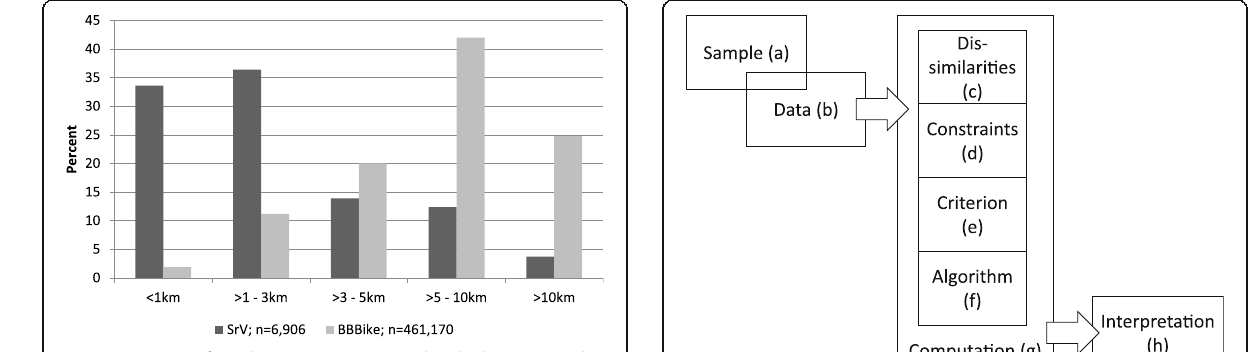
Fig. 3 Distances of BBBike requests compared with the municipal survey. The values describe the percentage of each length category on all trips in the respective dataset